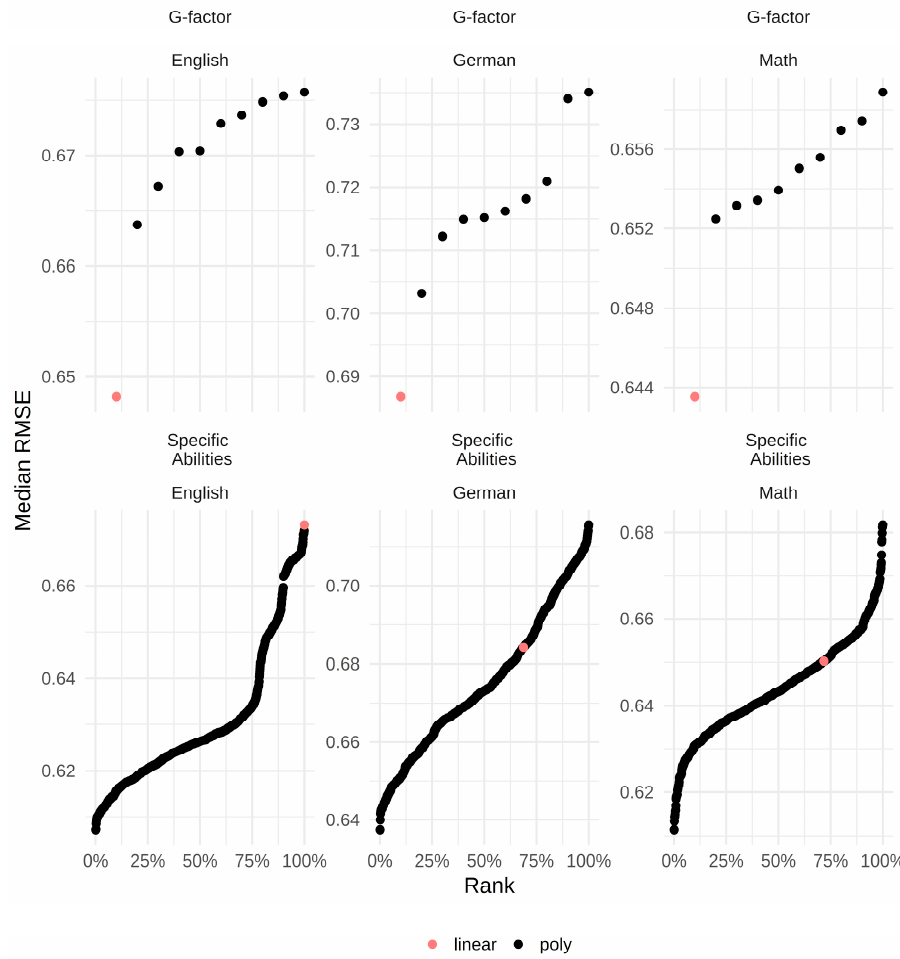
Figure 2. Ranked RMSEs for all models in ascending order. Percentiles on the x -axis. A red dot always represents the model with linear terms only.